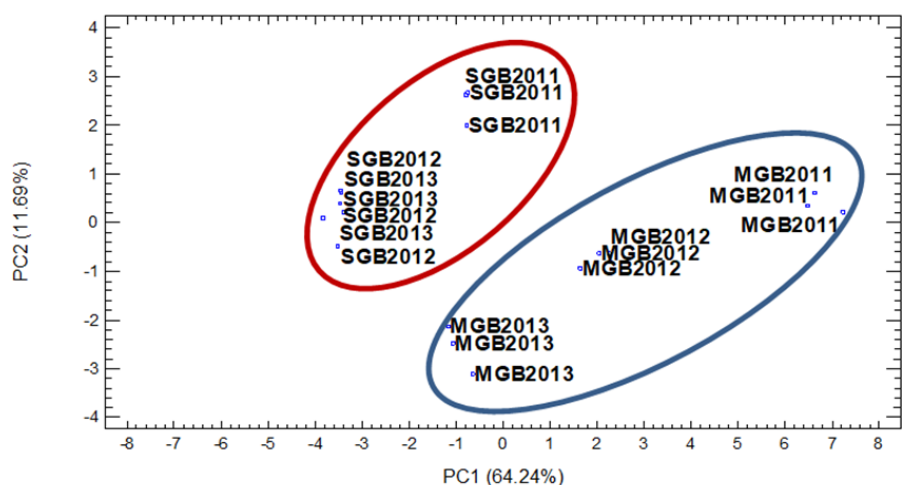
Figure 1. The scatter plot of distribution compounds of studied brandies: Muscat grape brandy (MGB) and standard grape brandy (SGB) for three consecutive vintages.